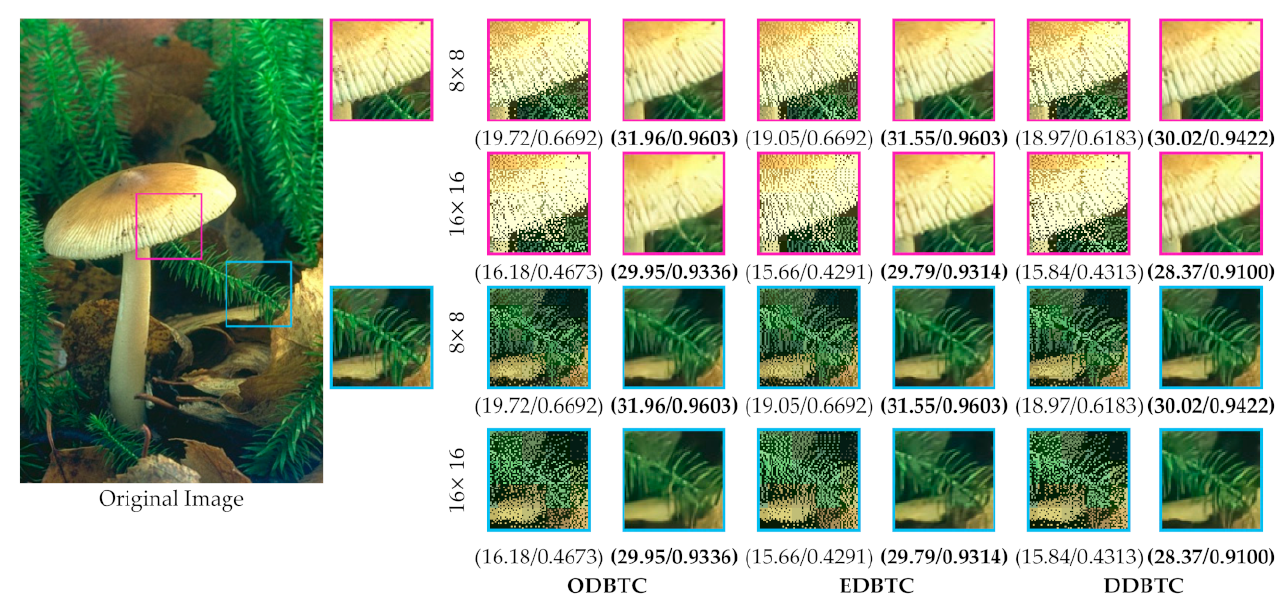
Figure 12. An example of image block alignment performed by the proposed networks: ( a ) ( d ) the final reconstruction image obtained by combining all those features.